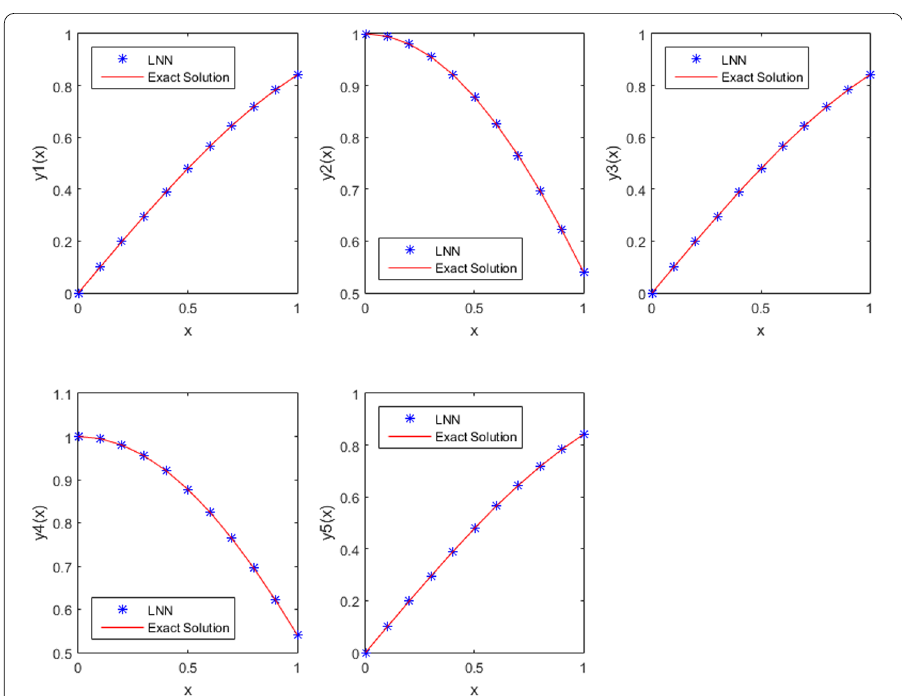
Figure 10 Comparison between exact and LNN results of Example